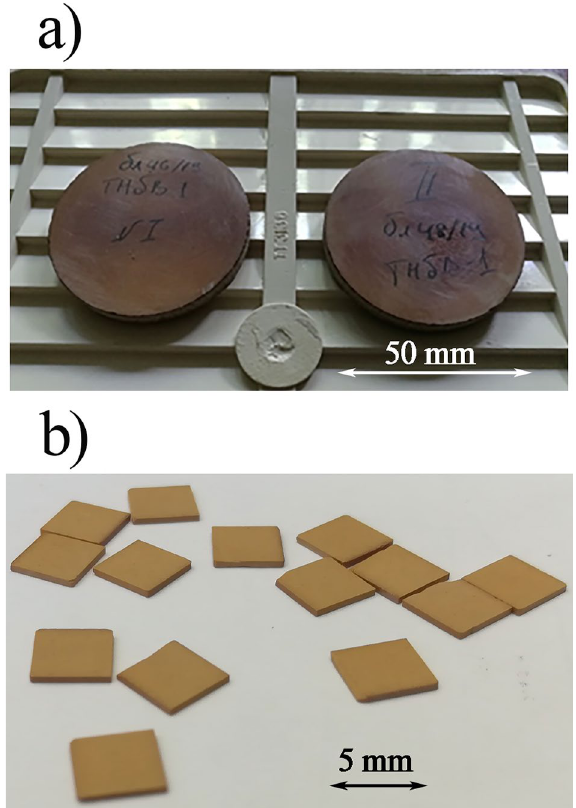
Figure 2. Photos of hot-pressed ceramic samples. ( a ) Appearance of Bi 3 TiNbO 9 samples after hot pressing, ( b ) Cut plate samples for electrophysical